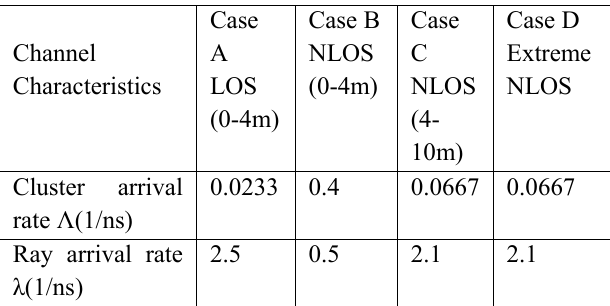
Table 1. UWB IEEE802.15.3a channel parameters